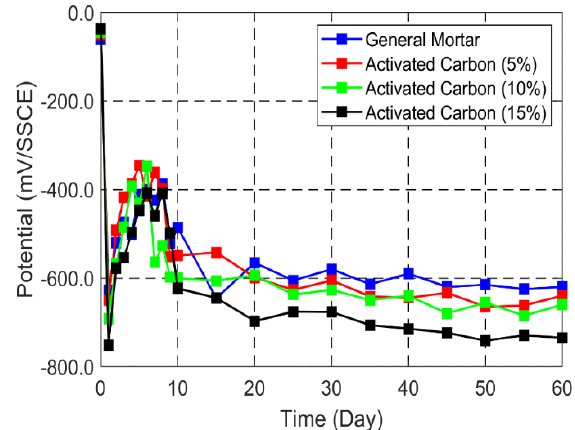
Figure 9. CP potential variations for 60